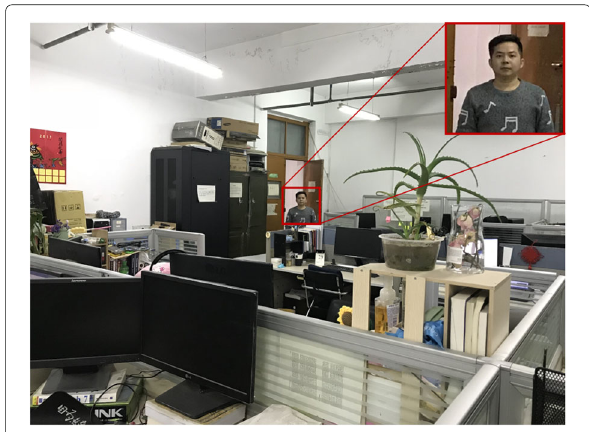
Fig. 1 An example of